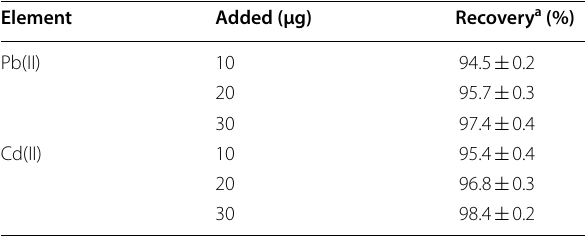
a Mean of 5 determinations with 95% confidence